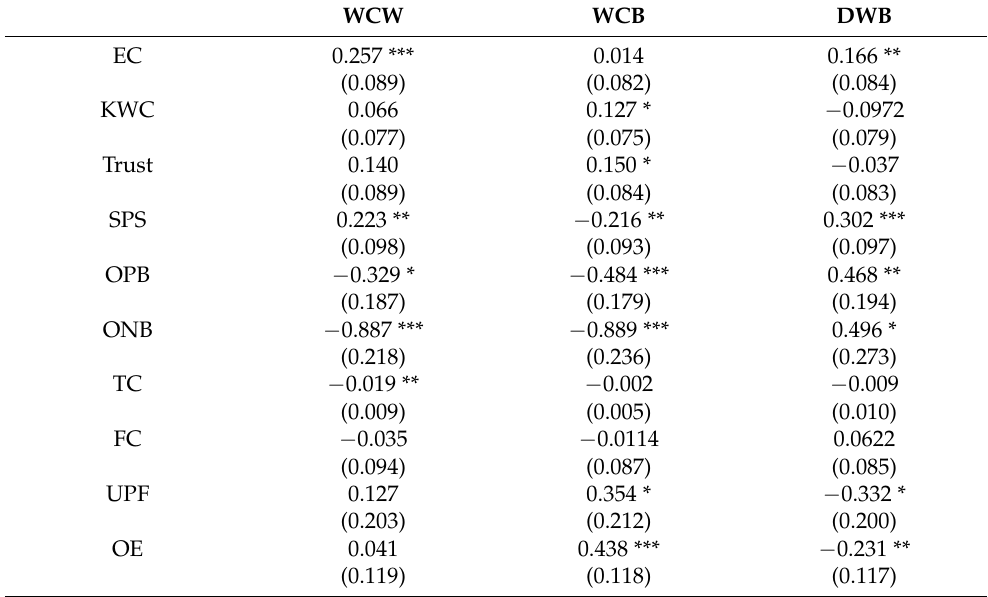
Table 4. The results of ordered logit